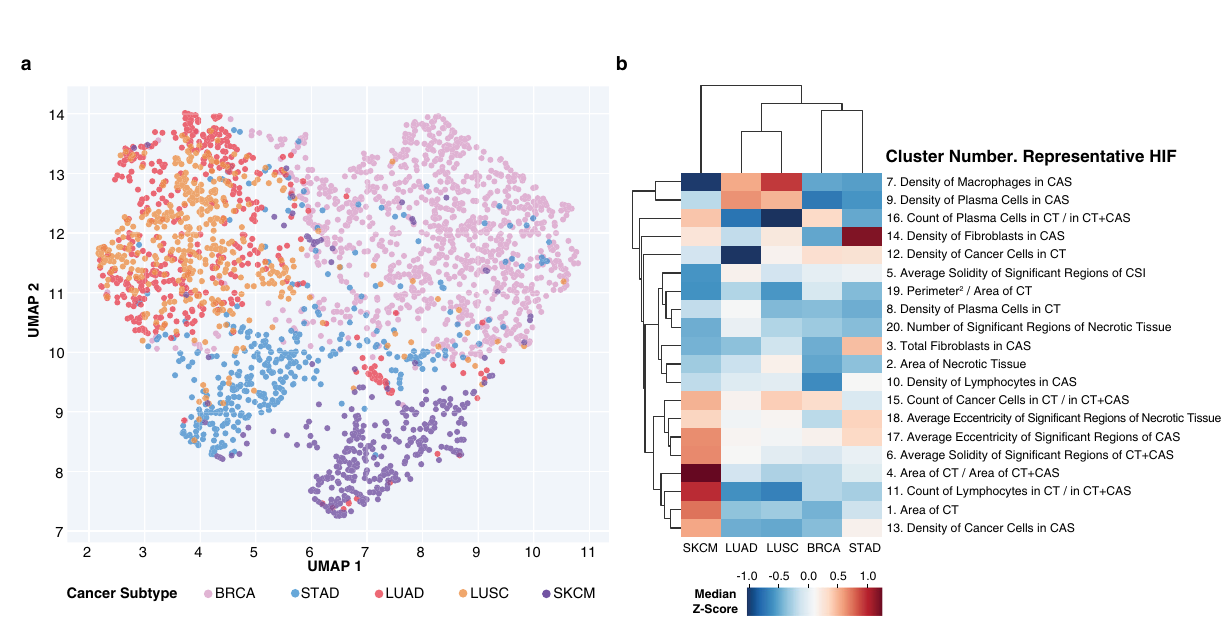
Fig. 3 Overview of HIFs. Graphical overview of the 607 human-interpretable image features (HIFs) grouped into six categories: cell-level count and density ( n = 56 HIFs), cell-level cluster ( n = 180), cell-level proportion and proximity ( n = 208), tissue-level area and multiplicity ( n = 13), tissue-level architecture ( n = 25), and tissue-level morphology ( n = 125). For each HIF, a histogram of the HIF quanti fi ed in all patient samples across the fi ve cancer types and histological snapshots corresponding to high and low values with the corresponding heatmap are shown. Both snapshots are taken from patient samples of the same cancer type. Cell- and tissue-type heatmaps adhere to the same color scheme described in Fig. 1c. In (iii), fi broblast clusters are annotated, contrasting one large cluster against multiple smaller clusters. In (iv), macrophage clusters and extents are annotated. Cluster extent is de fi ned as the maximum distance between a cluster exemplar (de fi ned via Birch clustering) and a cell within that cluster. Signi fi cant regions (viii) are de fi ned as connected components (identi fi ed at the pixel level) of a given tissue type with at least 10% the size of the largest connected component in the slide. A solidity (ix) of one corresponds to a completely fi lled object, while values less than one correspond to objects containing holes or with irregular boundaries. Fractal dimension (x) can ef fi ciently estimate the geometrical complexity and irregularity of shapes and patterns, thus capturing tissue architecture. A fractal dimension of one corresponds to a perfectly smooth tissue border, while higher fractal dimension corresponds to increasing roughness and irregularity, indicating more extensive physical contact between adjacent tissue types. The fractal dimension of the cancer – stroma interface (CSI) has been previously associated with dysfunction in antigen presentation 29 . Perimeter 2 /area (xi) is a unitless measure of shape roughness (e.g., square = 16, circle = 4 π ). Across all HIFs, tumor regions include cancer tissue (CT), cancer-associated stroma (CAS), and a combined CT + CAS. Cell- and tissue-type color coding is the same as Fig. 1c.